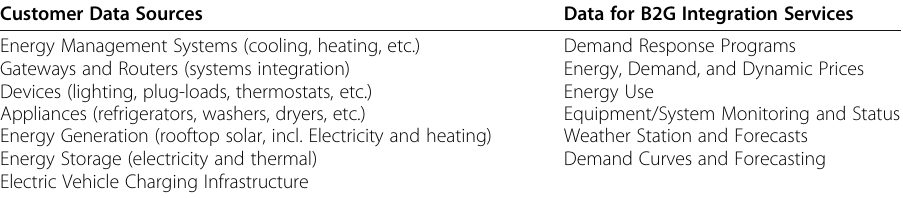
Table 1 Building and B2G Data sources Customer Data Sources Data for B2G Integration